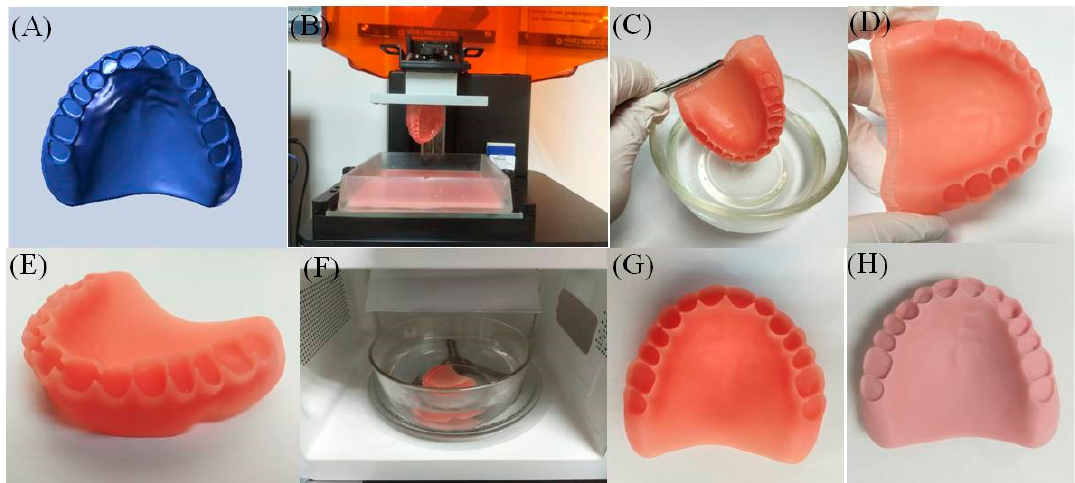
Figure 8. Printing process and product effect of denture base using PMMA resin and PMMA composite resin containing TiO 2 –1%-PEEK-1%. ( A ) Designing a base model; ( B ) printing and removing the base; ( C ) cleaning the base; ( D ) drying the base; ( E ) removing support and sanding; ( F ) secondary curing base; ( G ) 3D printed denture base using PMMA resin; and ( H ) PMMA composite resin containing TiO 2 -1%-PEEK-1%.